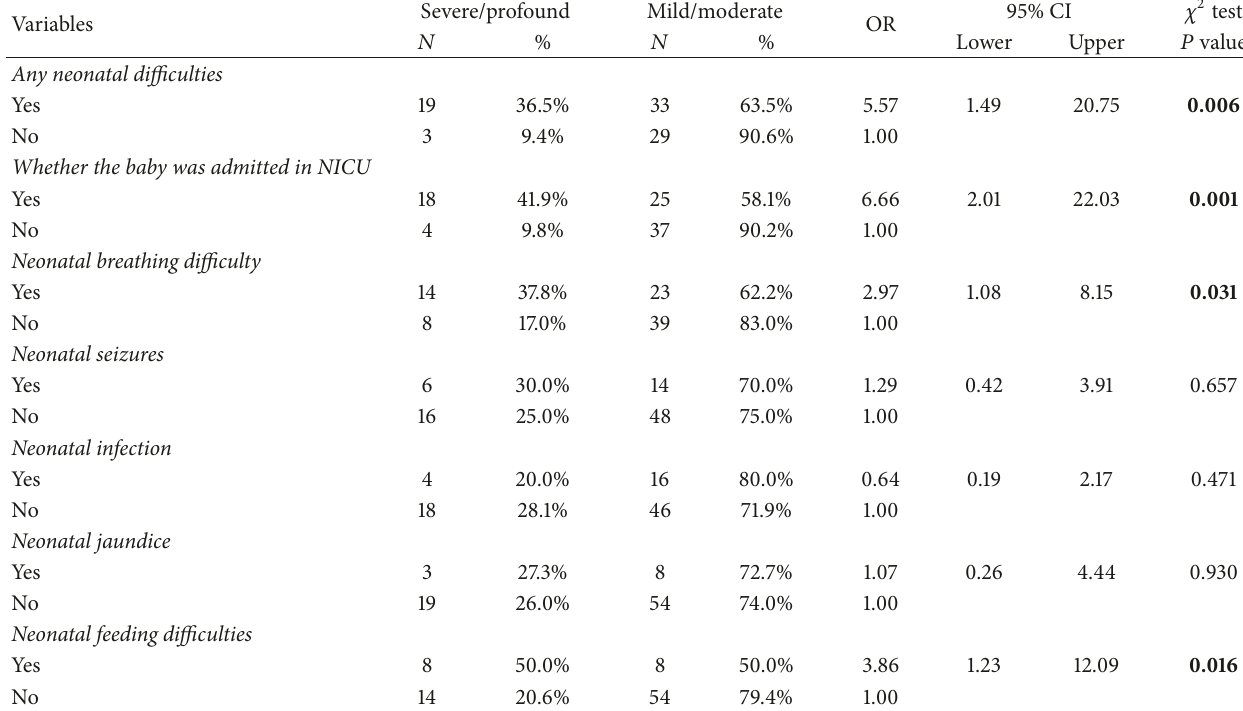
Table 7: Association between neonatal medical history of the children and severity of intellectual